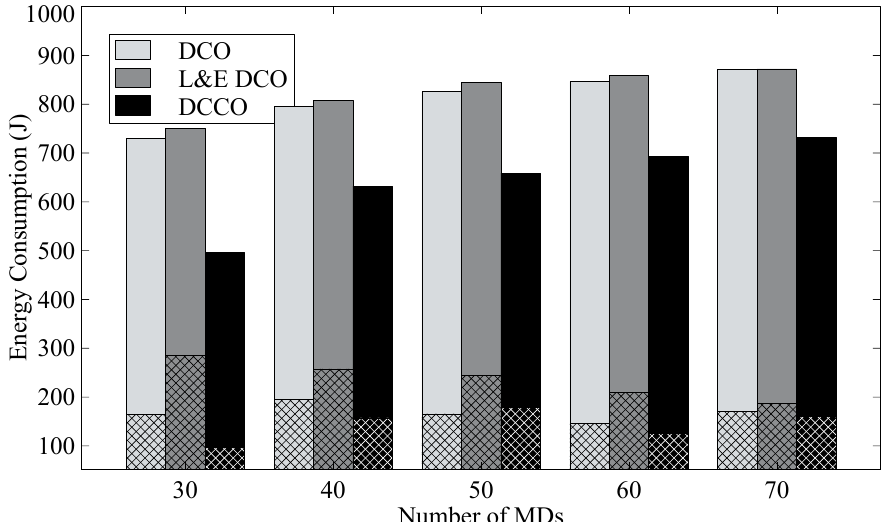
Figure 6. The average energy consumption with different